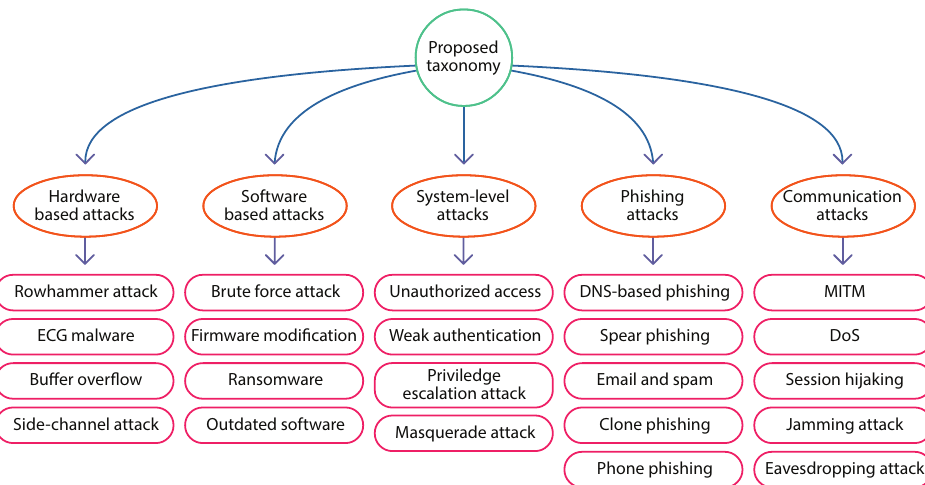
Figure 3. Taxonomy of different security attacks on a smart healthcare